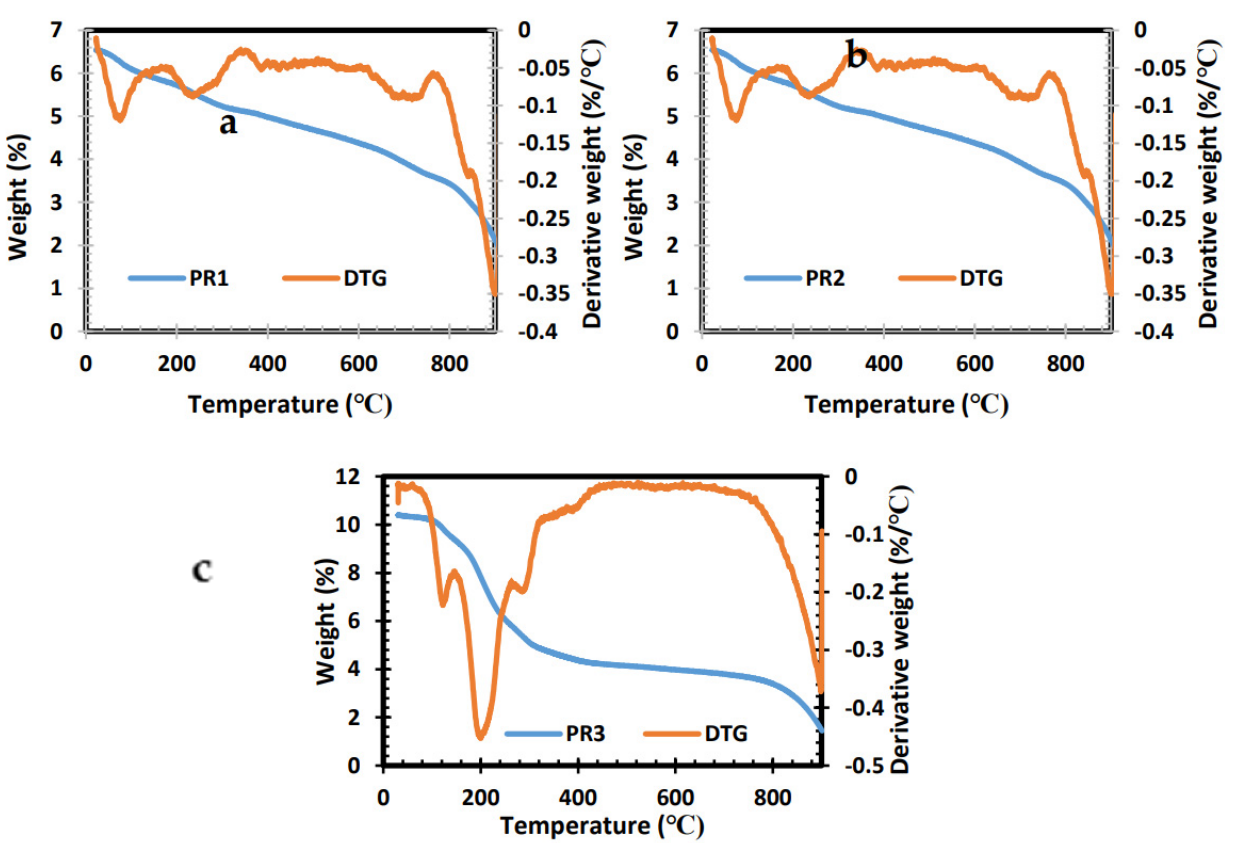
Figure 1. TGA and derivative thermogravimetric (DTG) analysis of PR1 ( a ), PR2 ( b ) and PR3 ( c ) complexes.